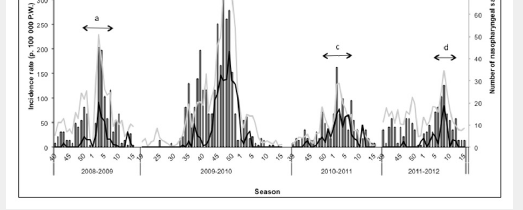
Incidence rate of acute respiratory infection (ARI) and medical consultation attributable to influenza, and number of nasopharyngeal samples taken , MISS network – influenza seasons 2008-2009 to 2011-2012. a = (ARI epidemic period for 2008-2009 season) : weeks 50-2008 to 7-2009; b = (ARI epidemic period for 2009-2010 season) : weeks 38-2009 to 51-2009; c = (ARI epidemic period for 2010-2011 season) : weeks 48-2010 to 7-2011; d = (ARI epidemic period